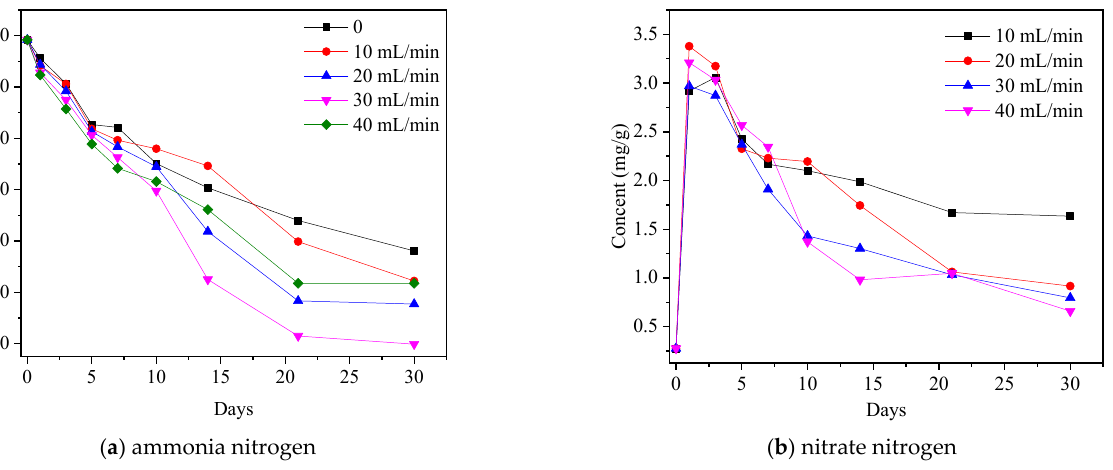
Figure 3. Variation of ammonia nitrogen/nitrate nitrogen content in sediments under aeration.